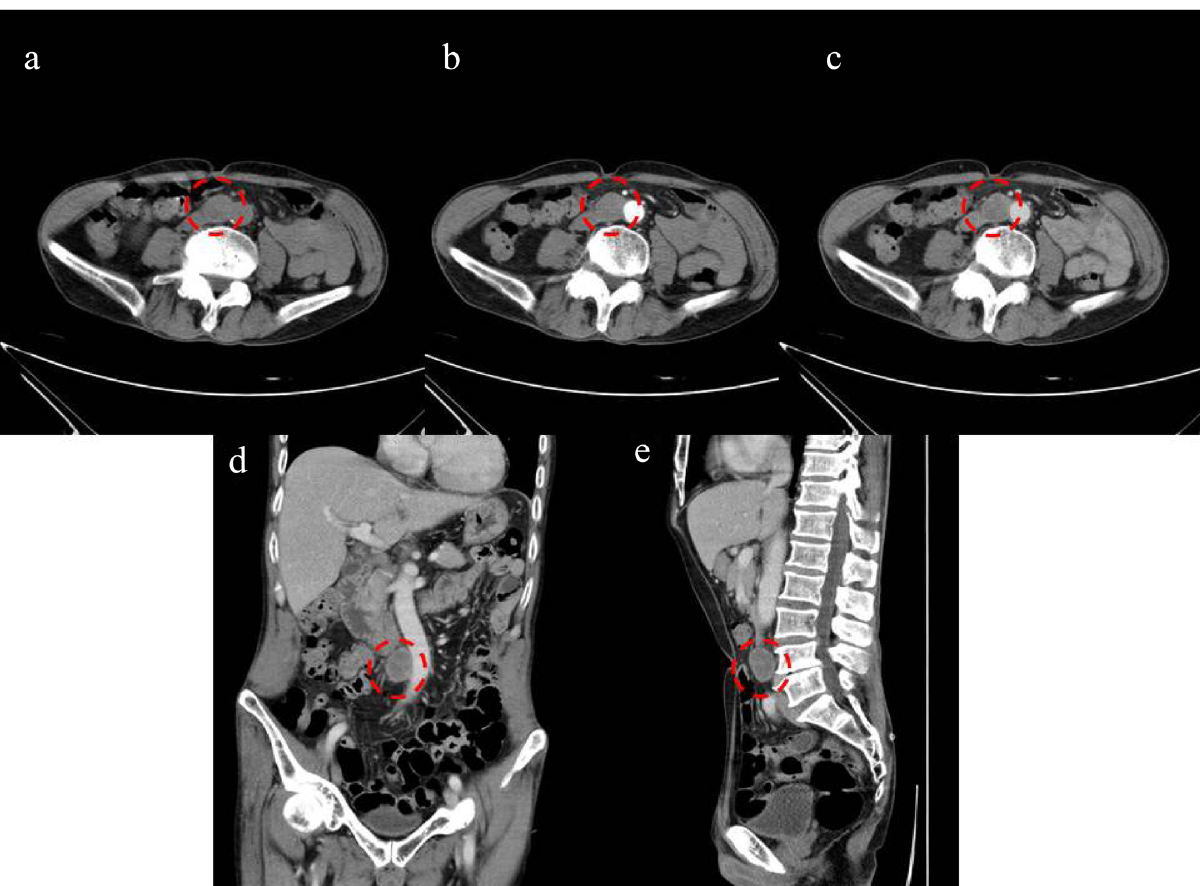
Figure 3: Contrast - enhanced CT of the abdomen. ( a ) Noncontrast - enhanced CT scan revealed an isointense solid mass with a clear boundary adjacent to the abdominal aorta ( red dashed circle ) ; ( b and c ) arterial and venous phase enhancement scans with mild enhancement of the mass ( red dashed circle ) ; ( d and e ) multiplanar reconstructed sagittal and coronal views revealed the adjacent relationship between the mass and the surrounding structures ( red dashed circle )